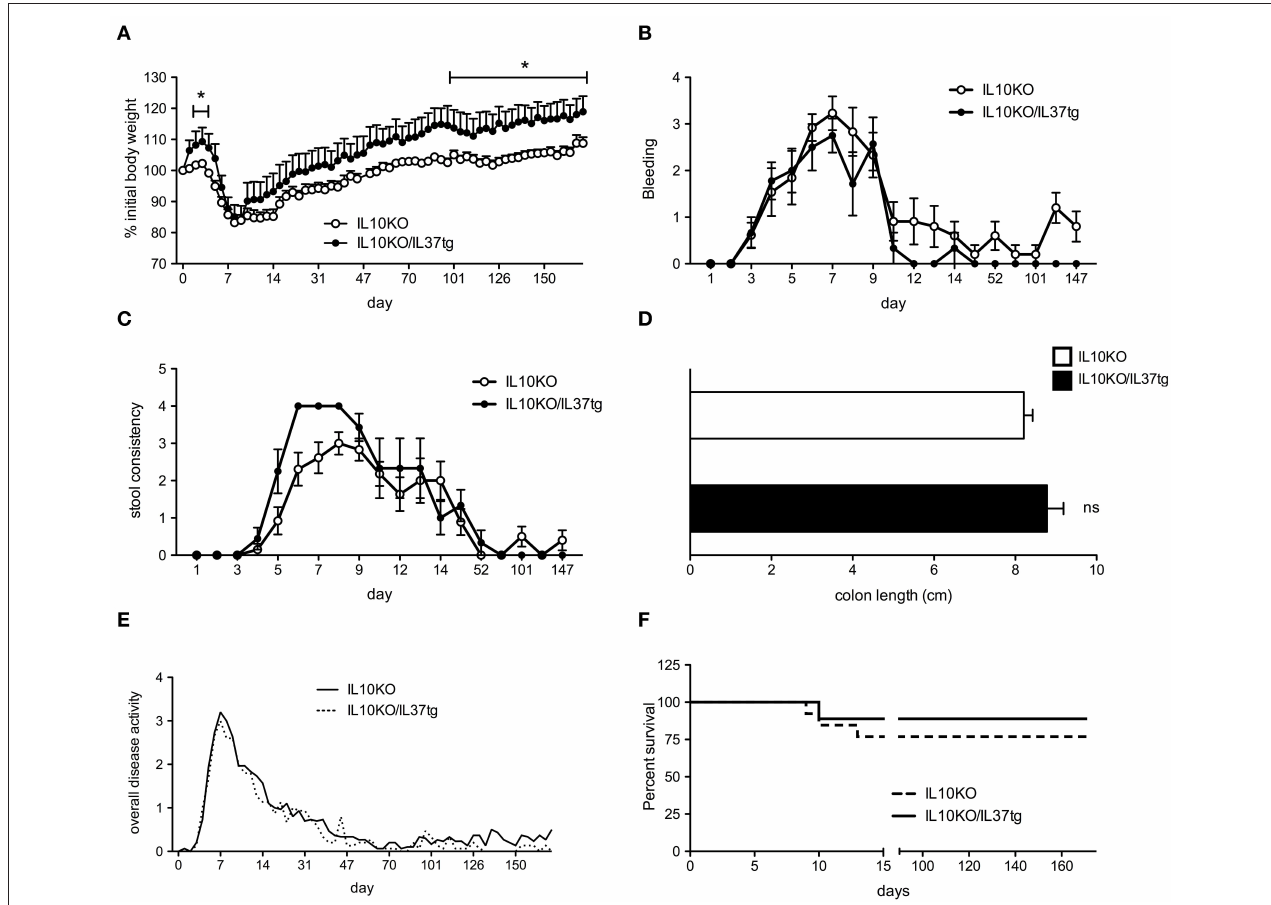
FIGURE 1 | Transgene IL-37 expression is associated with improved clinical outcome of chronic colitis in IL-10KO mice. Mild colitis was induced in IL-10KO/IL-37tg and IL-10KO mice which were scored in regards to (A) percent weight change (0: none, 1: − 5%, 2: 5–10%, 3: 10–15%, 4: > 15%), (B) blood in the stool (0: normal, 2: slight bleeding, 4: gross bleeding), (C) stool consistency (0: normal, 2: loose stool, 4: watery diarrhea) and (D) colon length (E) Overall disease activity: Clinical severity of colitis (stool consistency, weight loss and fecal blood) were recorded daily for the first 15 days and three times weekly thereafter (F) Overall survival. Open circles/bars: IL10KO ( n = 10), closed circles/bars: IL-10KO/IL-37tg ( n = 5). * p < 0.01. Statistical significance tested with